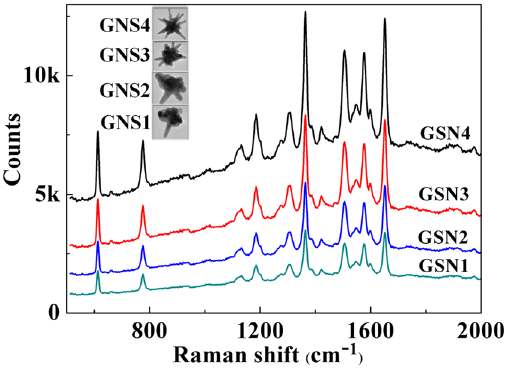
Figure 4. SERS spectra of R6G at a concentration of 1 × 10 − 7 M using SERS probes from GNS1 to GNS4, respectively. The laser wavelength is 514